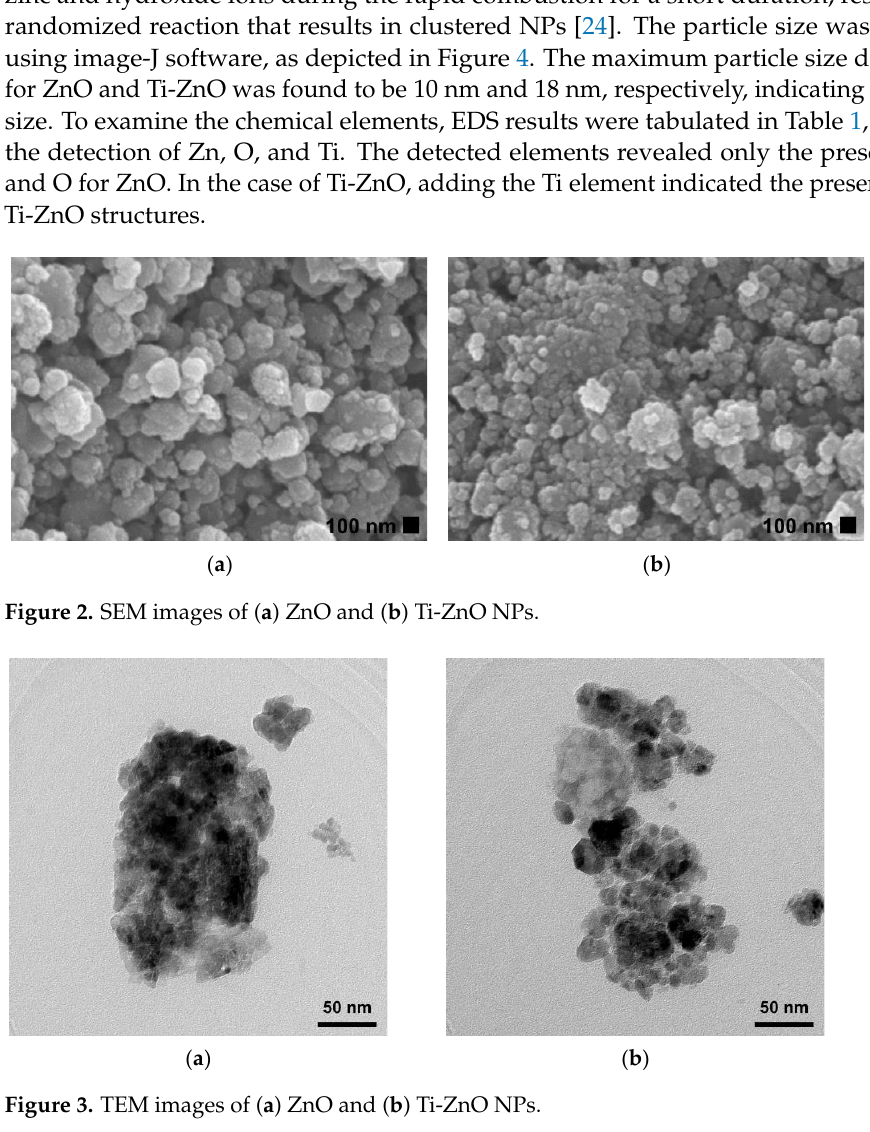
( b ) Figure 4. Particle size distribution of ( a ) ZnO and ( b ) Ti-ZnO NPs. Table 1. Detected chemical composition of ZnO and Ti-ZnO using EDS. Sample